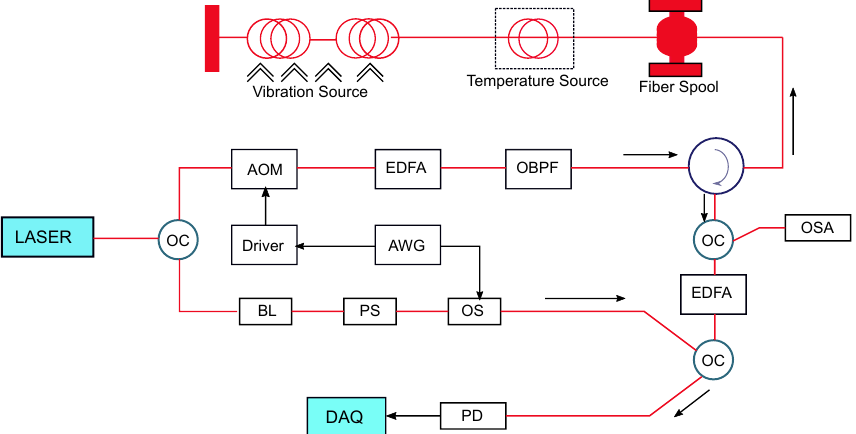
Figure 14. Experimental setup of the distributed simultaneous temperature, vibration and strain sensing system. AOM: Acousto-Optic Modulator, EDFA: Erbium-Doped Fiber Amplifier, BPF: Band-Pass Filter, PZT: Piezoelectric Transducer, AWG: Arbitrary Waveform Generator, BL: Brillouin Laser, PS: Polarization Scrambler, OS: Optical Switch, PD: Photo-Detector, DAQ: Data Acquisition. (Adapted from